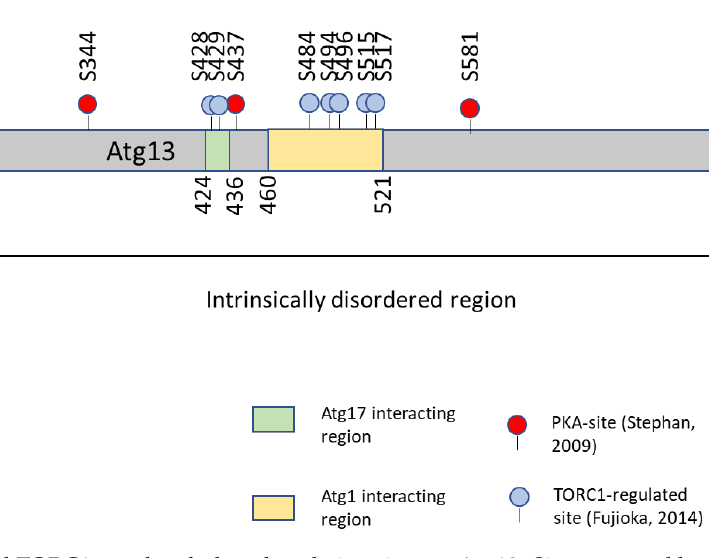
Figure 4. PKA- and TORC1-regulated phosphorylation sites on Atg13. Sites reported by Stephan, 2009 are shown in red and by Fujioka, 2014 in blue. The position of the Atg17-interacting region is indicated by a green and the Atg1-interacting region as a yellow rectangle.